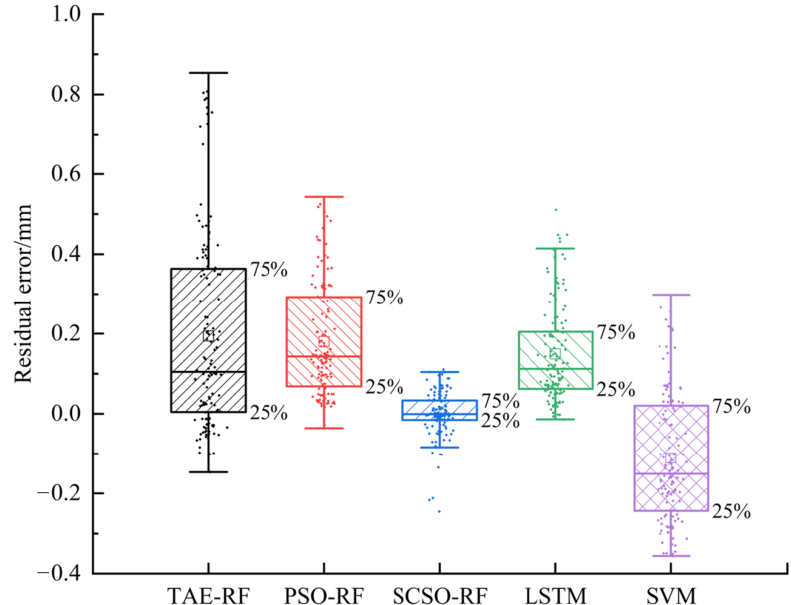
Figure 14. Comparison of residuals of models.